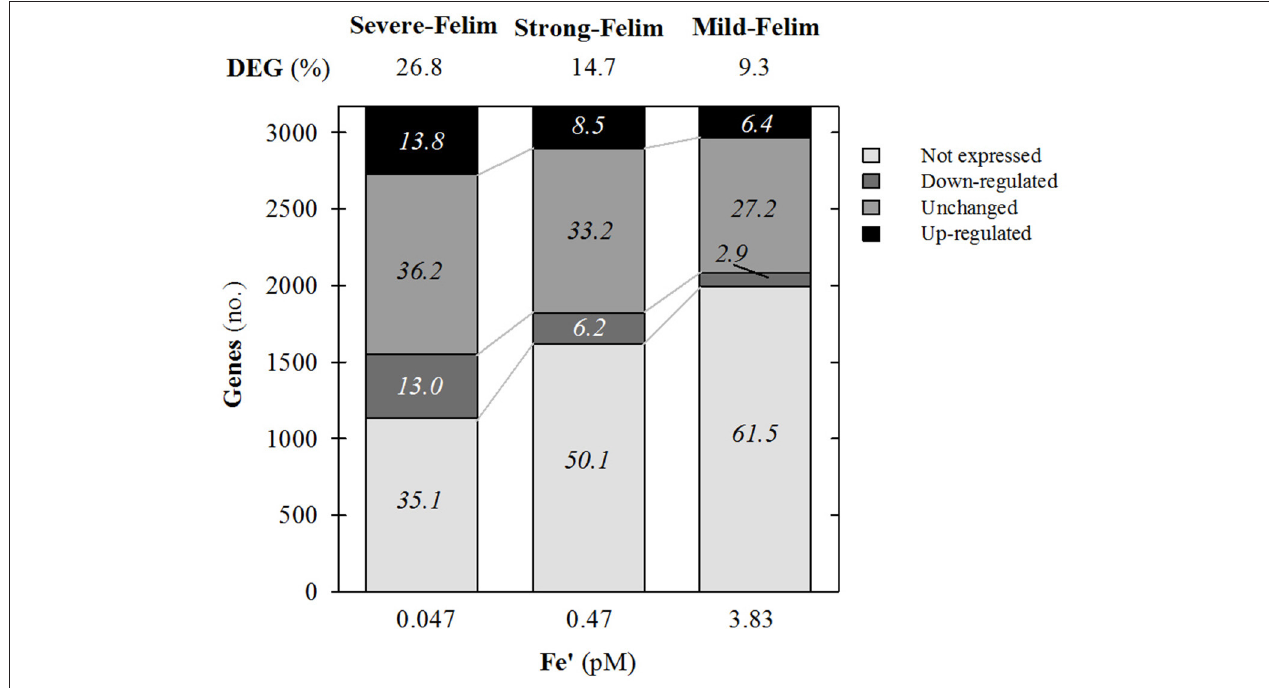
FIGURE 3 | General features of the whole genome transcription response of Synechococcus sp. PCC7002 in response to iron (Fe) limitation. Relative change in expression compared to Fe replete condition. Values on top indicate the percentage of differentially expressed genes (DEG). Values on stacks indicate the relative contribution to the whole genome in